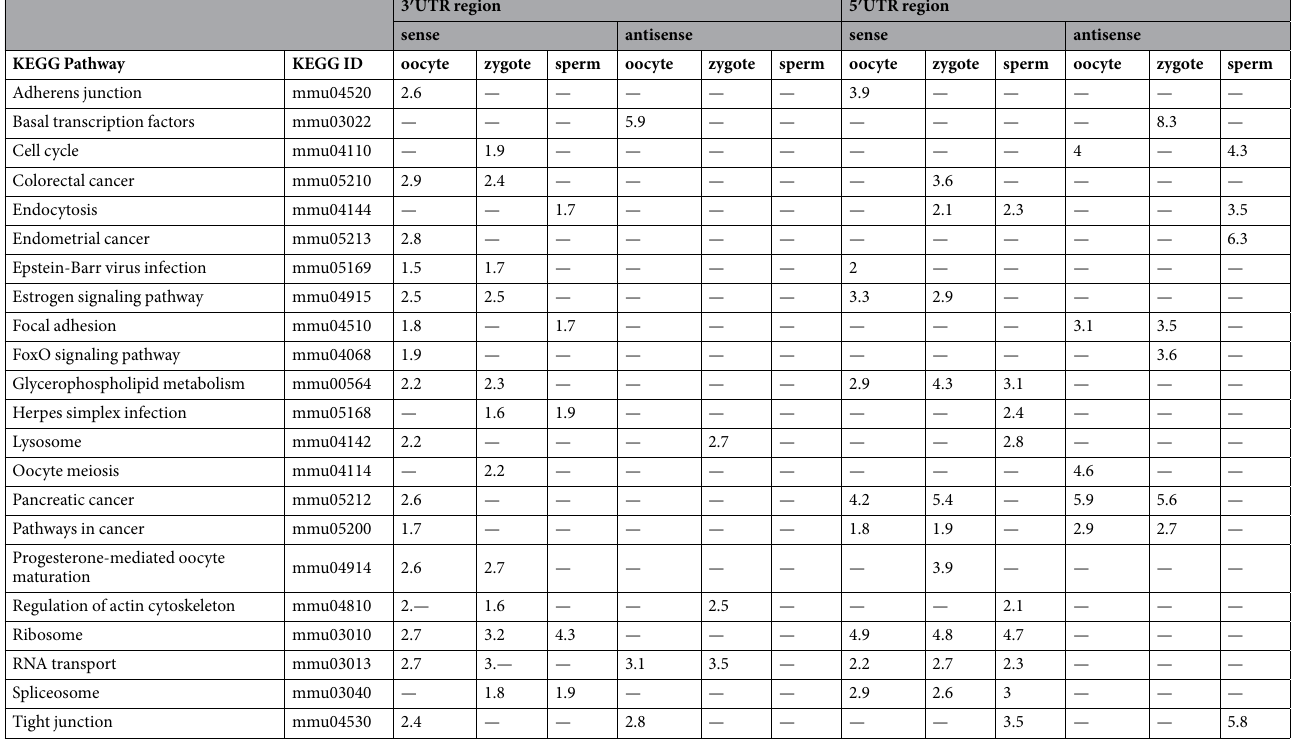
Table 4. Common enriched KEGG pathway transcripts with 3 ′ and 5 ′ UTR associated RapiRNAs. Numbers indicate the fold enrichment value of pathways after DAVID enrichment analysis using transcripts with RapiRNAs associated to their 3 ′ and 5 ′ UTRs.